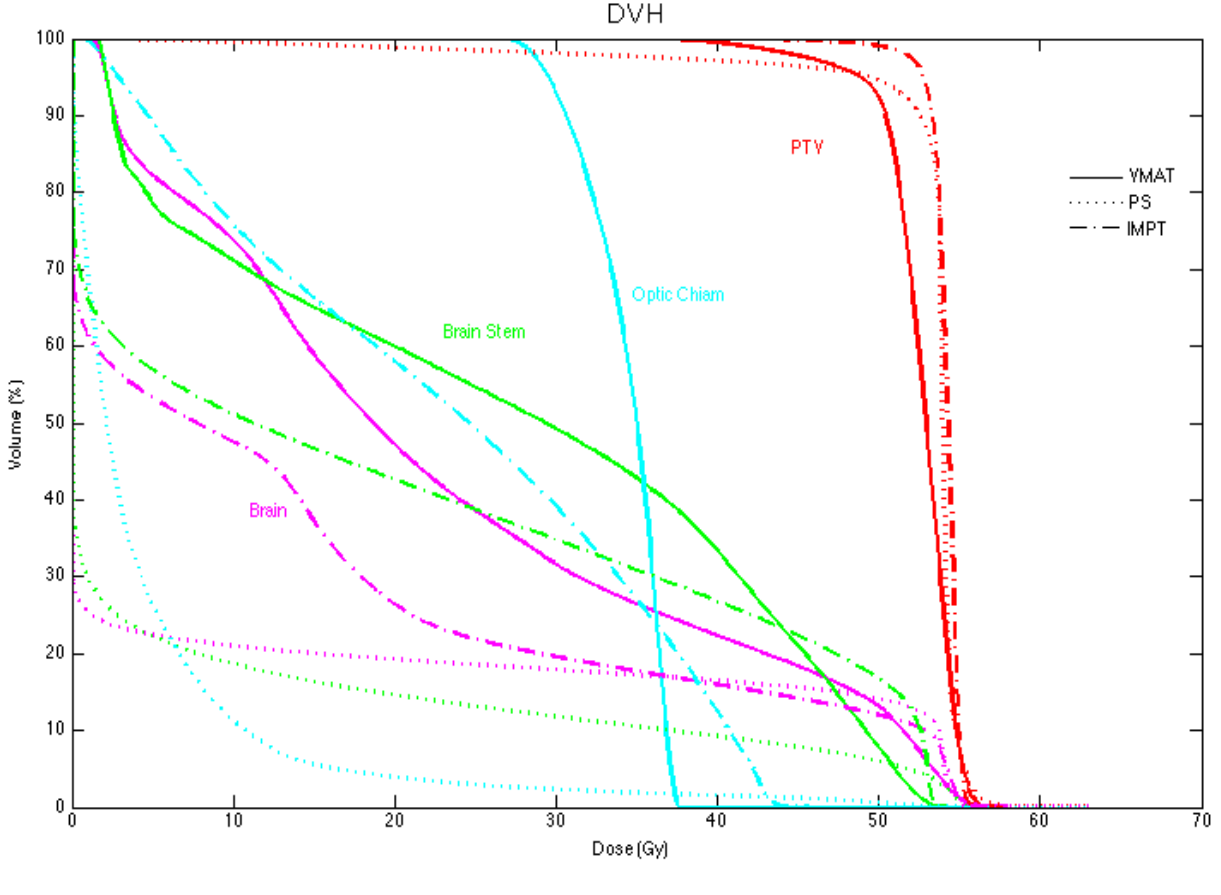
Figure 3. The dose volume histograms (DVH) for patient 5. VMAT plans are represented with the solid lines, PSPT with the dotted lines and IMPT with the dash-dot lines. Different regions of interest are represented with different colored lines.